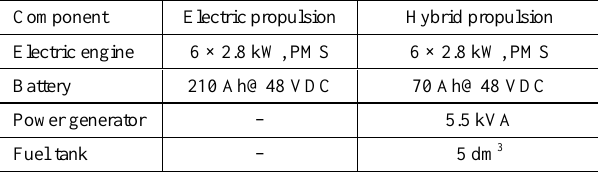
Table 1. Vehicle’s power transmissions main components parameters